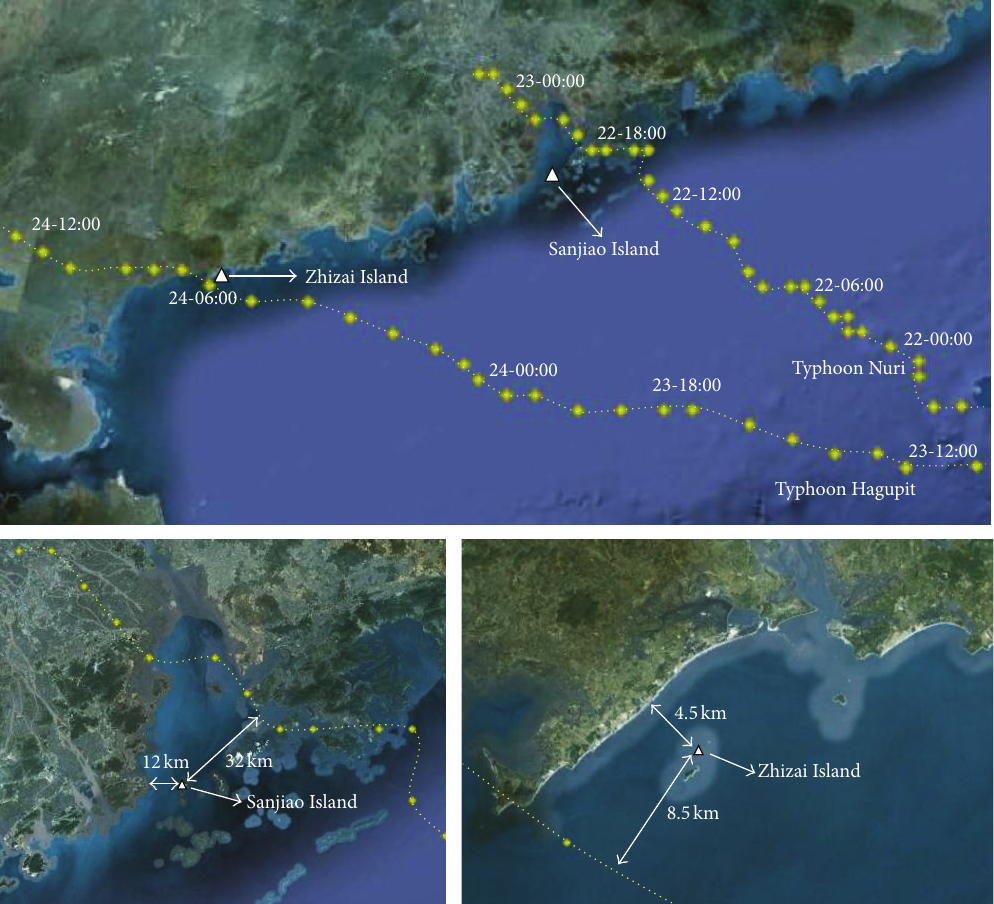
Figure 1: Typhoon tracks (yellow dotted lines) and positions of the observation sites Zhizai Island and Sanjiao Island. The distance between northeastern coast of Macao and the Sanjiao Island is about 12km, and the shortest distance between the 100m high observation tower sites at Zhizai Island and the coast is 4.5 km. The center of typhoon Nuri passed the tower at 18:50 on August 22, 2008, and the shortest distance from Sanjiao Island to typhoon center is about 32km. The center of typhoon Hagupit passed the tower at 05:10 on September 24, 2008, and the shortest distance from Zhizai Island to typhoon center is about 8.5 km.